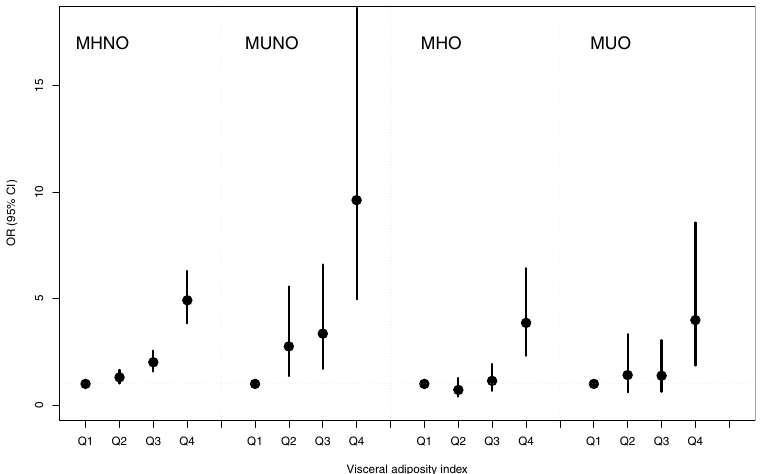
Figure 3. Adjusted odds ratios (OR) and 95% confidence intervals (CI) for hyperuricemia risk associated with visceral obesity index within each metabolic obesity phenotype defined by HOMA criteria. Vertical bars are 95% CIs. The adjusted OR was obtained from Model 3: adjusted for age, sex, urban/rural resident, smoking status, alcohol status, white blood cell, total cholesterol, blood pressure, glucose and hs-CRP. Abbreviations : HOMA, homeostasis model assessment of insulin resistance; MHNO, metabolically healthy non-obese; MUNO, metabolically unhealthy non-obese; MHO, metabolically healthy obese; and MUO, metabolically unhealthy